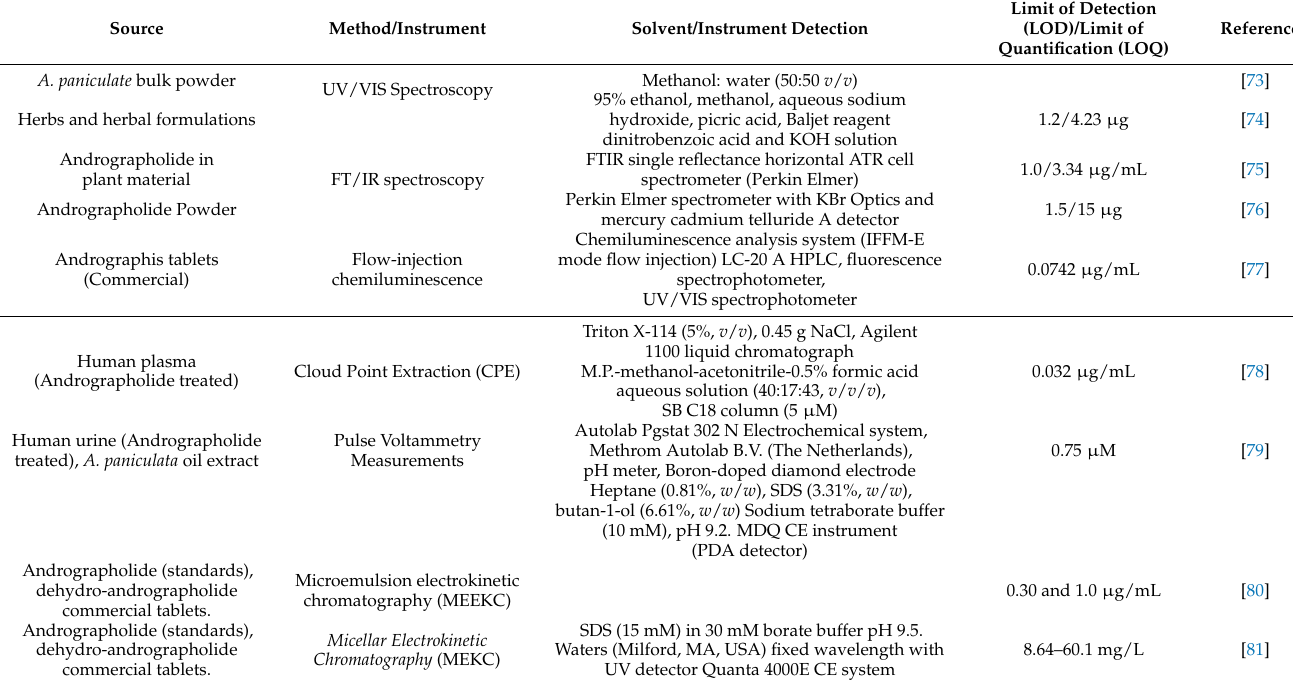
Table 2. Advancement in methods for quantitative estimation of andrographolide (AGL) from various herbal, multi-complex mixtures, and biological